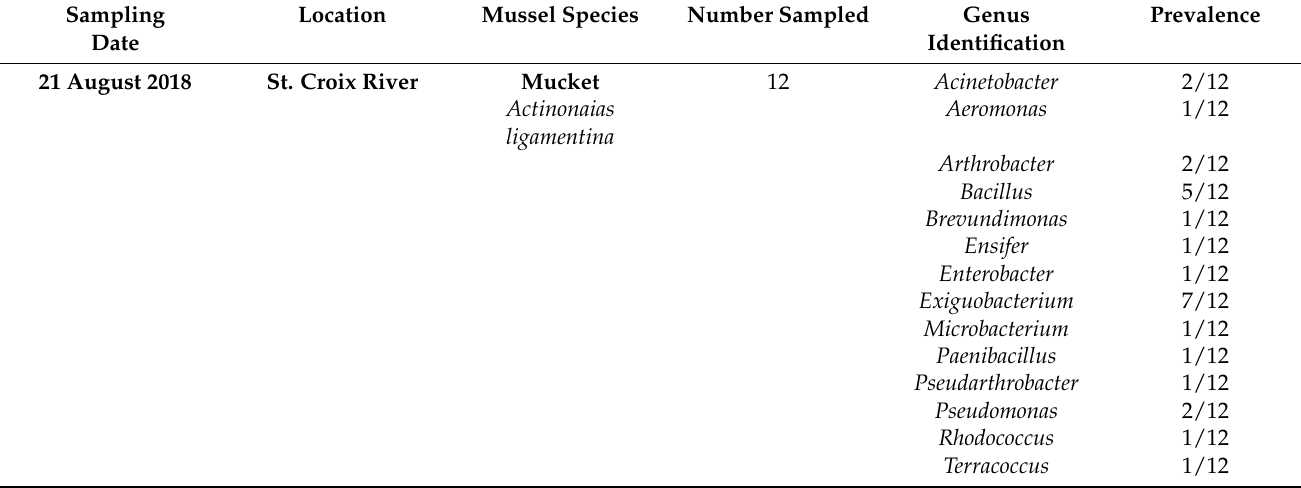
Table 1. Bacterial genera isolated from the hemolymph of mussel species from rivers in the Midwest- ern United